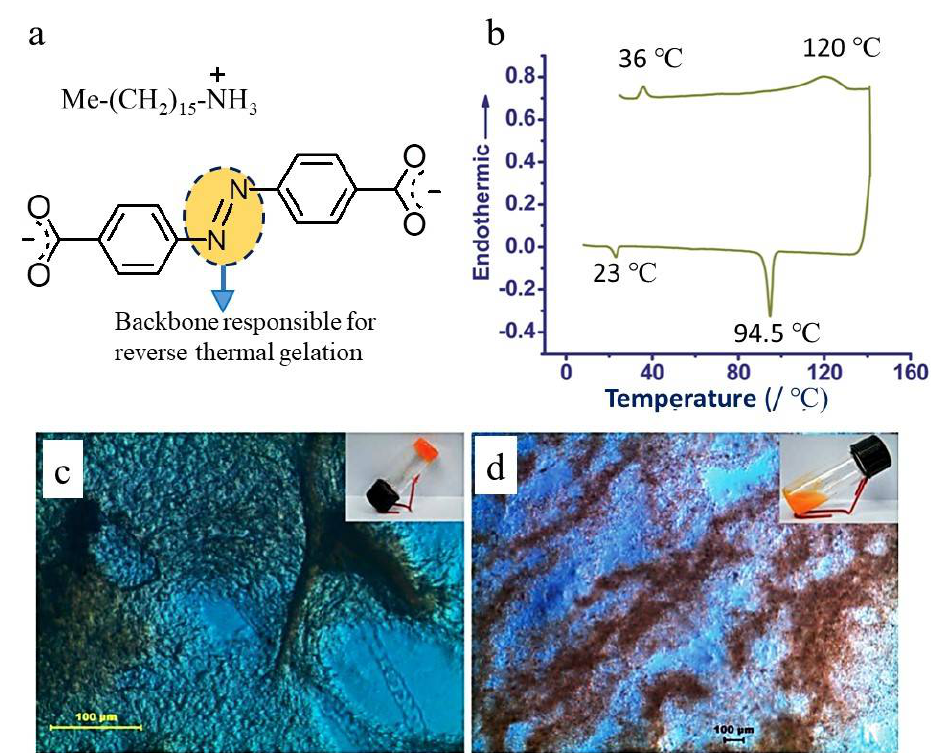
Figure 3. Reverse thermal gelling behavior of dicarboxylate salts. ( a ) Heat-set gel derived from hexadecylammonium azobenzene-4,4′-dicarboxylate. ( b ) DSC of 5.0 wt % DMSO gel (the heating and cooling scan was 10 °C min −1 ). ( c ) HOPM of the semitransparent heat-set gel, made with chloro-benzene (bp 132 °C); the image was taken at 180 °C in an open atmosphere (Scale bar 100 μm). ( d ) Formation of colloid during a cooling cycle at room temperature (Scale bar 100 μm) (Figure 3b–d adapted with permission from Ref. [6]. 2012, Royal Society of Chemistry)